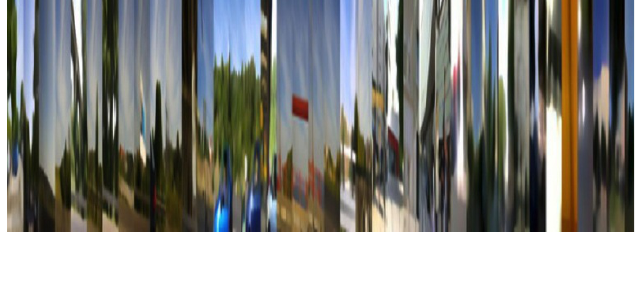
Fig. 4. Output color map number1 test using photos from Fig. 3.